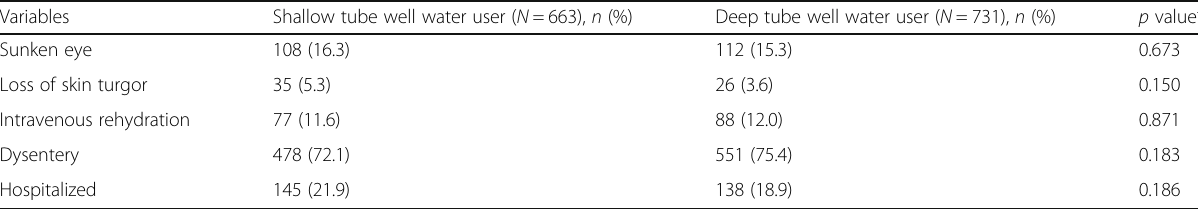
Table 1 Enrollment features of study